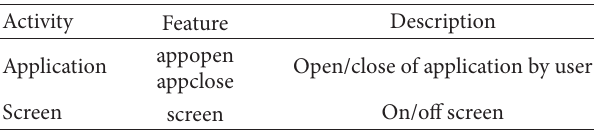
Table 3: Monitoring features for user activity.